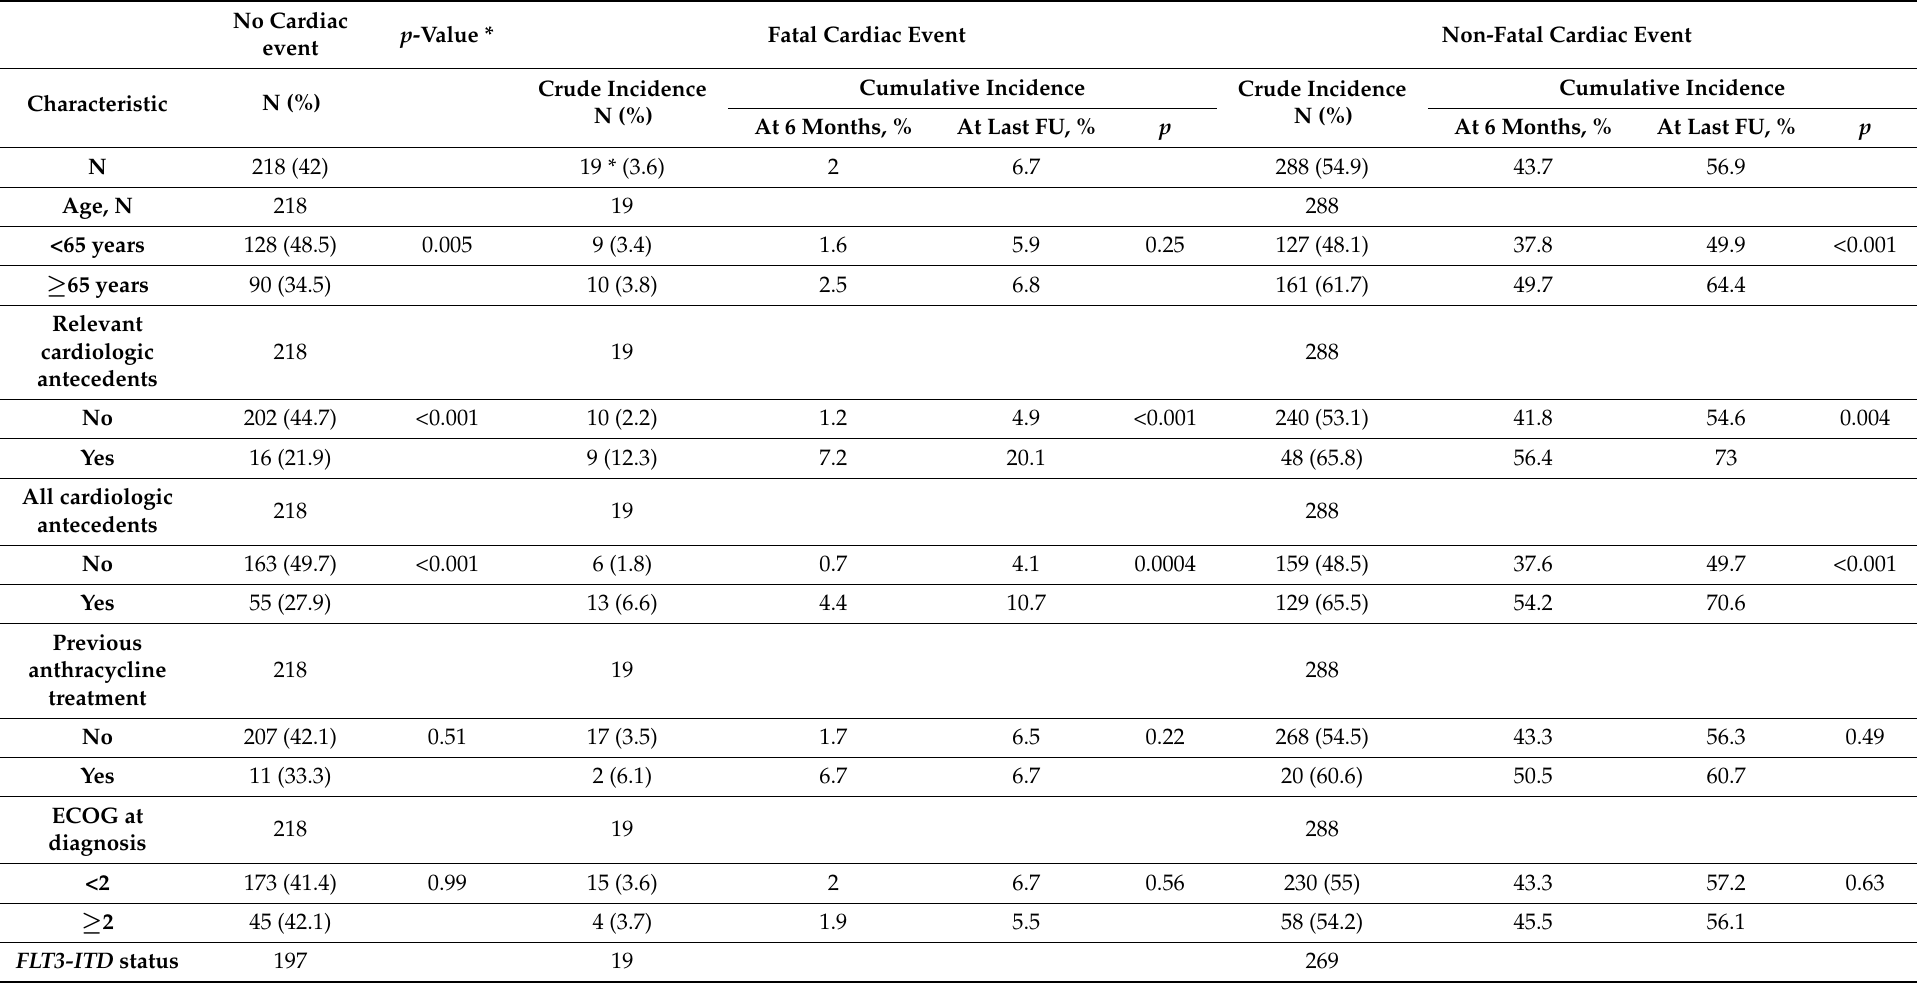
Table 3. Overall cohort: Crude and cumulative incidence of cardiac events (fatal vs. non-fatal vs. no cardiac event) according to demographic, clinical, and biological characteristics of patients at